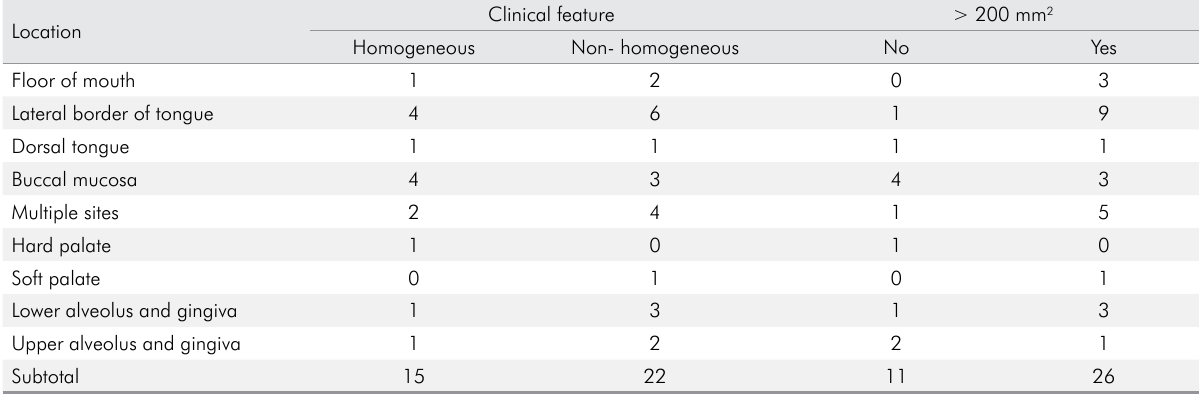
Table 1. Clinical characteristics and locations of oral leukoplakias (n = 37)